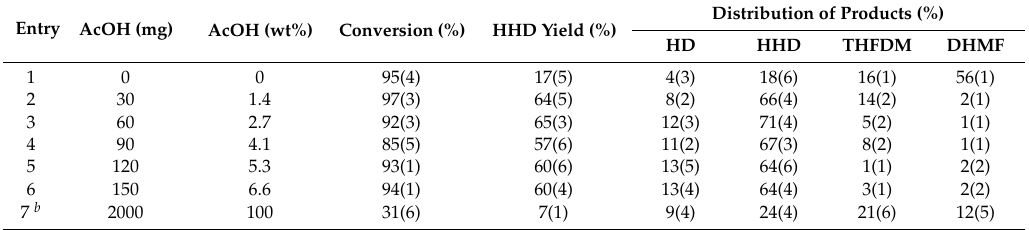
Table 1. Hydrogenation of HMF on Pd / C with di ff erent amount of AcOH a